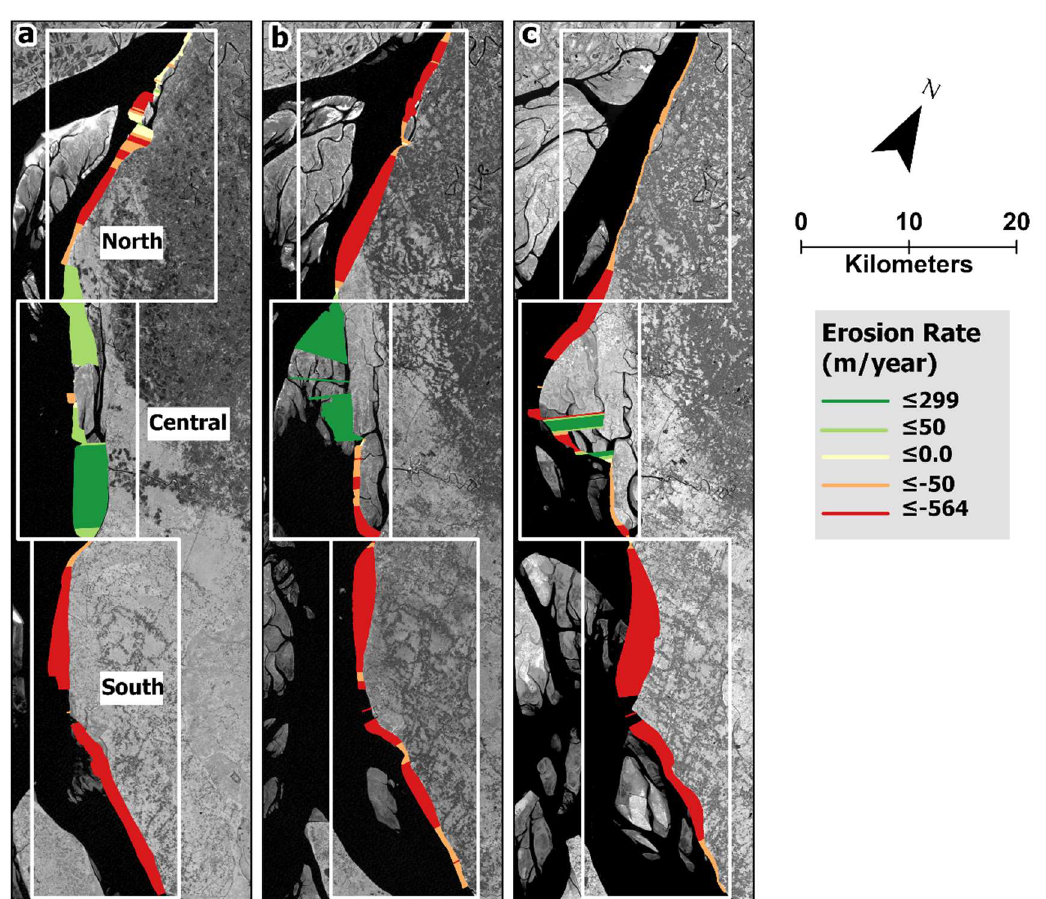
Figure A1. Decadal shoreline movement in the eastern bank of the lower Meghna River region in Bangladesh: ( a ) 1990–1999, ( b ) 2000–2009, ( c ) 2010–2019. In the map, positive values indicate accretion and negative values indicate erosion.